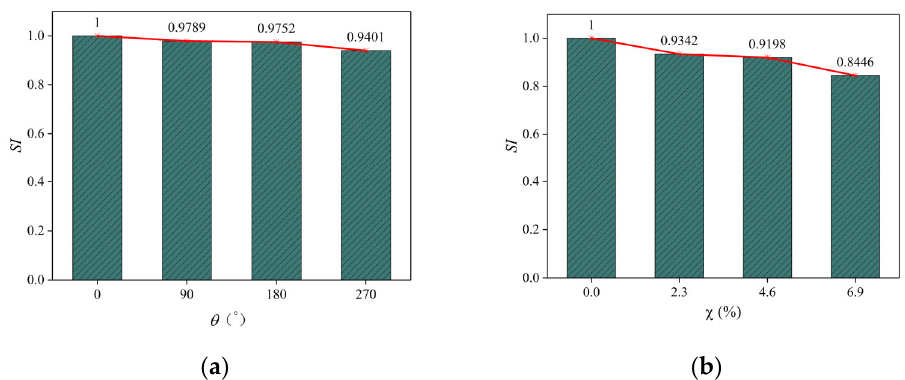
Figure 9. SI of BWCFST specimens with different initial imperfections: ( a ) BWCFST with interfacial gap; ( b ) BWCFST with spherical-cap gap.